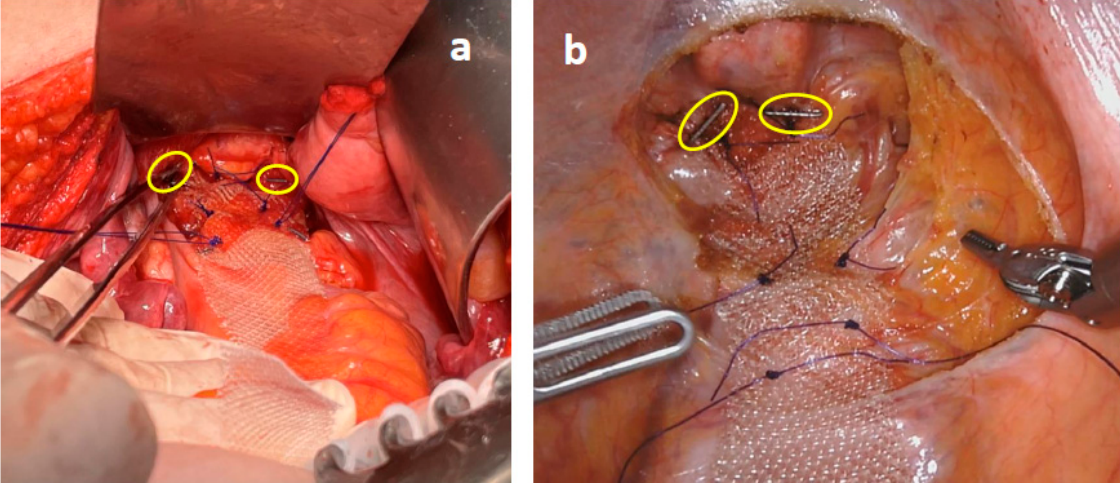
Figure 3. The mesh was sutured over the ventral rectum with three couples of 3-0 PDS stitches in open ( a ) and robotic ( b ) surgery. Two radiopaque clips were positioned at the distal edge of the mesh (circles).